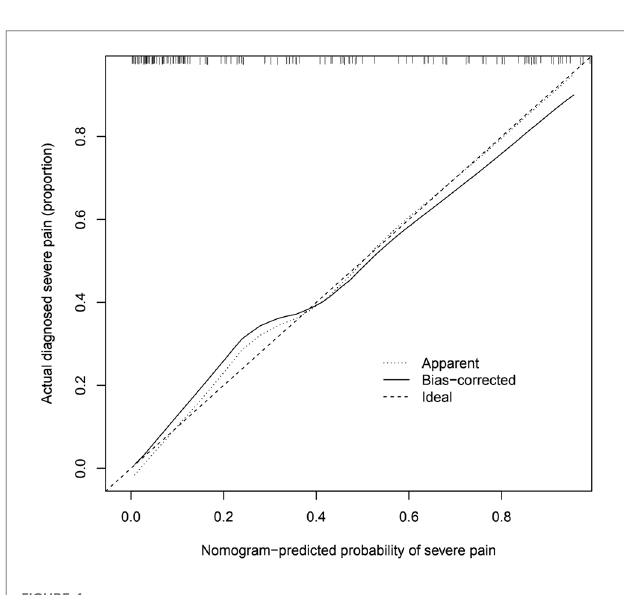
FIGURE 4 Calibration diagram of nomogram of modeling